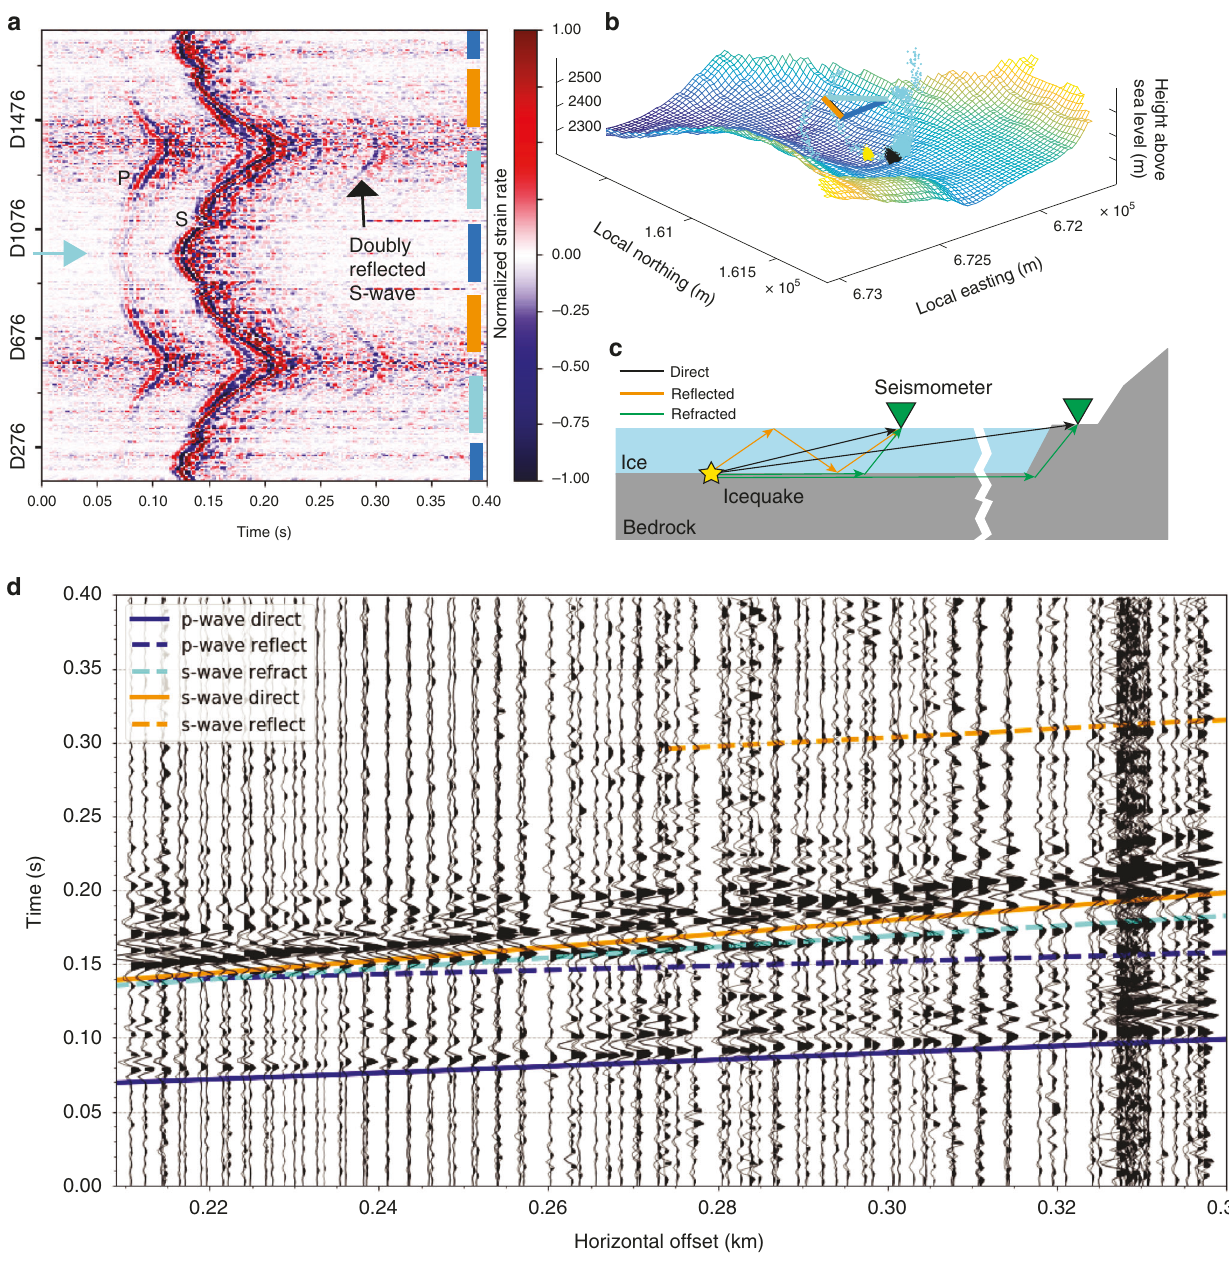
Fig. 4 Record sections and probabilistic source location of stick-slip event. a Full DAS record of normalized stick-slip seismogram. The DAS laser is re fl ected at the cable end near Channel D988 (cyan arrow). Higher channels sample similar cable locations to the ones below Channel D988 giving similar (though not identical) strain rate seismograms causing a symmetrical appearance with respect to Channel D988. The bar colors on the panel right correspond to the cable segment colors of panel ( b ) and Fig. 1b, indicating channel locations (space in between the colored bars corresponds to cable loops). P- and S arrivals are indicated. Differences in relative P and S amplitudes result from the double-couple radiation pattern of the stick-slip event and different angles between wave polarization and cable axis. b Bedrock topography (color corresponds to elevation) and location of stick-slip event: black and cyan dots, respectively, indicate location grid search using arrival times of the DAS and seismometer records of the event shown in panel ( a ). Yellow point cloud is the location of the event shown in Supplementary Fig. 11. Point density is proportional to location probability density. The seismometer arrival times give rise to side lobes and larger location uncertainties than the DAS arrival times. Triangle represents cable layout with colors corresponding to bars on the right of panel ( a ). c Schematic of waves traveling between stick-slip icequake and recording stations. d Record sections and theoretical arrival-time estimates using an adjusted 2D velocity model of ice over bedrock (see Methods for P-wave (Fig. 4c). The latest indicated arrival (best illustrated in The refracted and doubly re fl ected S-wave arrivals are also Fig. 4a at around 0.3 s) points toward a doubly re fl ected shear visible in on-ice seismometer records (Fig. 3b). However, without wave arrival, although the calculations place the arrivals slightly the dense sensor layout of the DAS cable, these phases are more after the signal onset, which likely results from our simpli fi ed 2D dif fi cult to interpret. On the DAS system, Fig. 4d shows additional velocity model. coherent arrivals after the direct S-arrival. These may be other